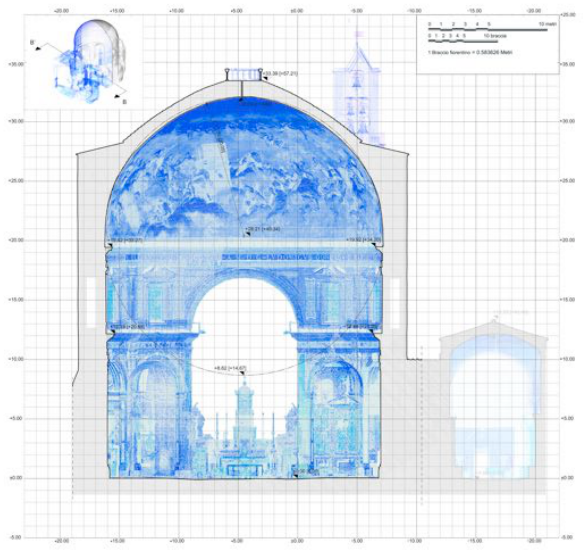
Figure 7: Cross section of the the Tribuna of the Basilica of Santissima Annunziata from the 3D point cloud mode (original drawings scale 1: